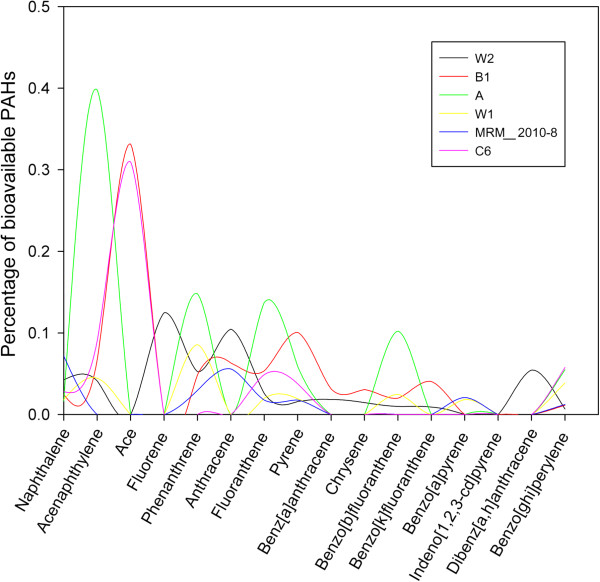
Distribution of bioavailable proportions of PAHs, expressed as percentage of total extractable contents.